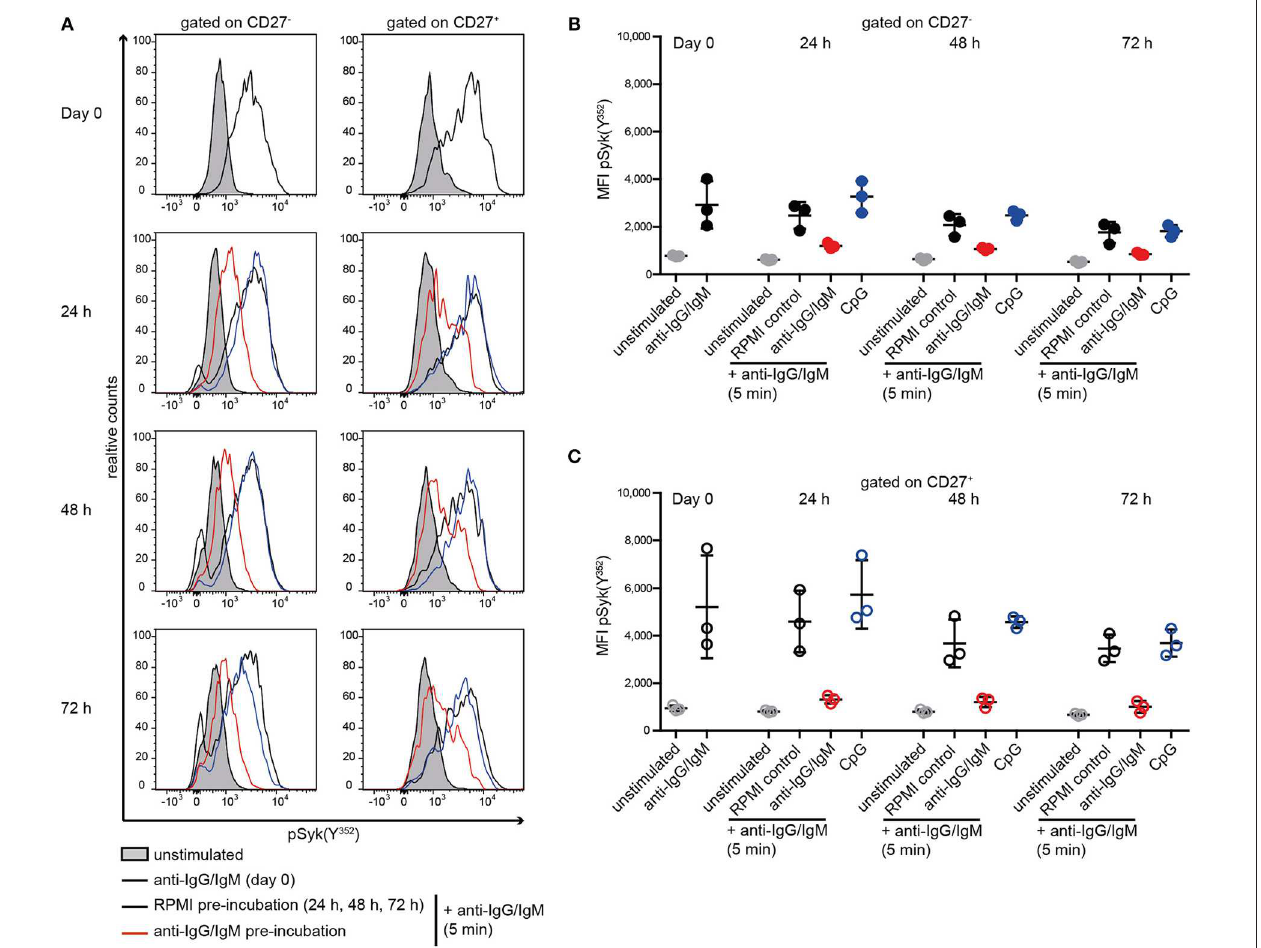
FIGURE 3 | Reduced Syk(Y 352 ) phosphorylation upon re-stimulation of the BCR. PBMCs from HD were incubated with anti-IgG/IgM, CpG, or RPMI as a control for 24, 48, or 72h and re-stimulated with anti-IgG/IgM for 5min. (A) Representative histograms of Syk(Y 352 ) phosphorylation at day 0 and without (black line) or with anti-IgG/IgM (red) or CpG (blue) pre-incubation for 24, 48, or 72h. The unstimulated control is shown as a gray peak. Anti-IgG/IgM induced pSyk(Y 352 ) MFIs in (B) CD27 − B cells (solid dots) and (C) CD27 + B cells (open circles) at day 0 or after pre-incubation with RPMI as a control (black), anti-IgG/IgM (red), or CpG (blue) for 24, 48, and 72h. Unstimulated controls are displayed as gray dots. Horizontal lines represent means ± SD [n(HD) = 3].